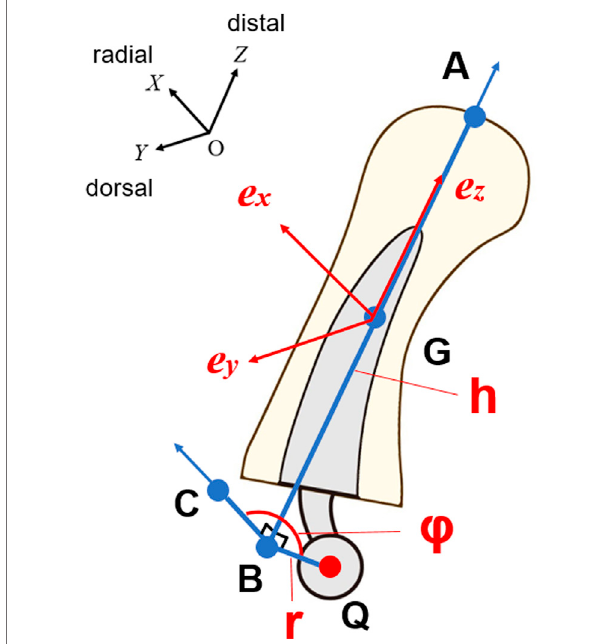
FIGURE2| Coordinatesystemforvirtualidealball-and-socket implants. AB: bone axis, G: center of gravity, C: point at distance r from point B in positive X axis direction, e: unit vectors from center of gravity to coordinate